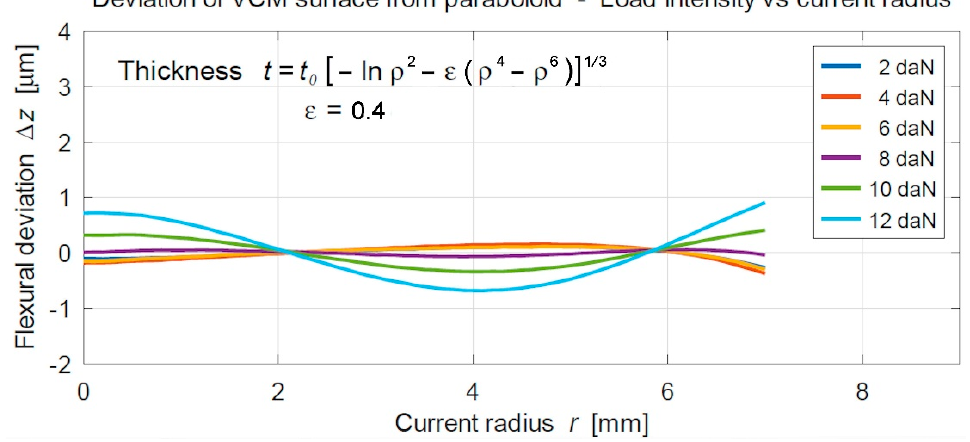
Figure 9. Flexural deviations from paraboloid for central forces up to F =12 daN over a 14 mm aperture diameter. In the range F ≤ 10 daN over 13 mm aperture diameter, deviations to a paraboloid remain smaller than 0.6 µ m PTV, i.e., 0.1 µ m RMS.